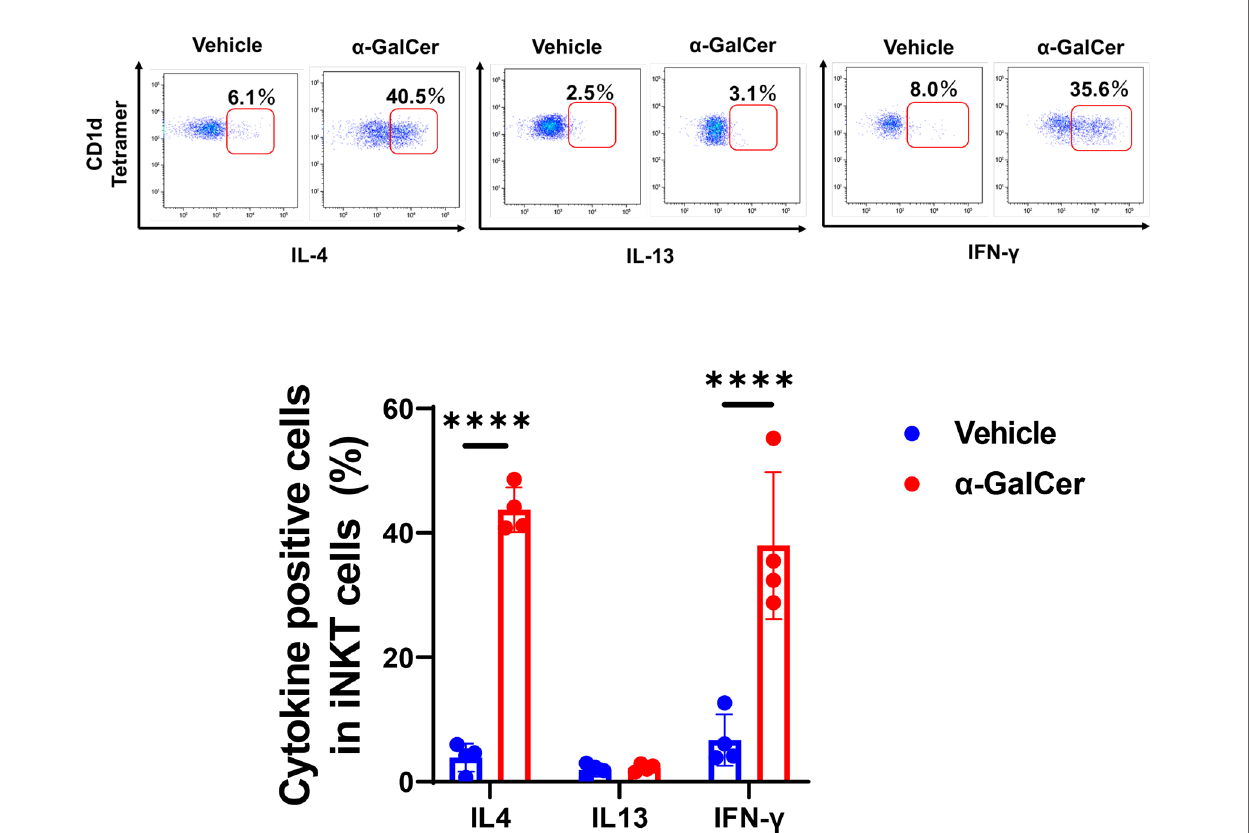
FIGURE 3 | Production of cytokines from iNKT cells after hepatic I/R injury. Representative dot plots in liver iNKT cells at 6 h post-reperfusion (upper panels). The percentage of IL-4-, IL-13-, and IFN- g -positive cells in iNKT cells in mice treated with a -GalCer or vehicle (lower panel). Data are expressed as the mean ± SD (four biological replicates per group). **** P <